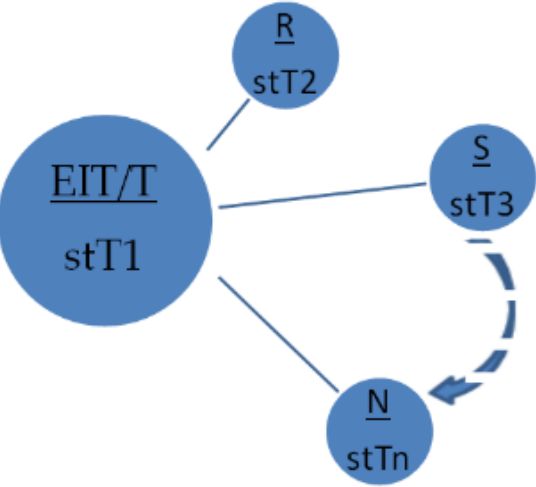
Figure 1. Principle scheme of one EIT with n agents system.